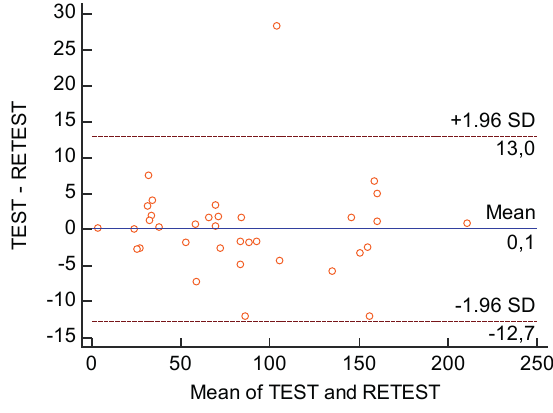
Figure 1 - Bland & Altman confidence limits for